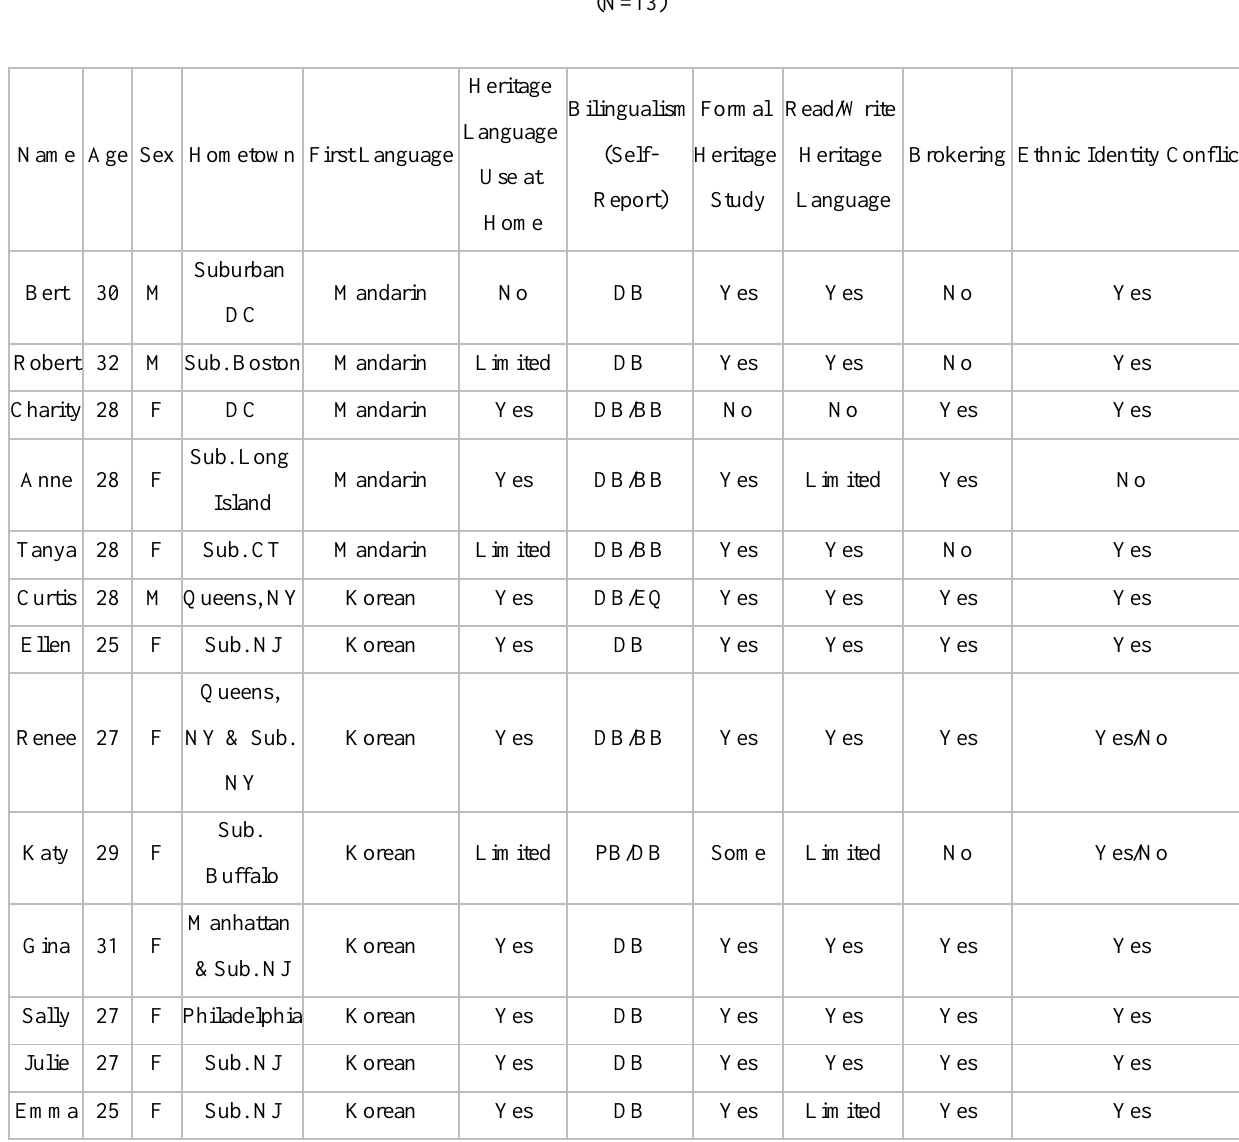
Background Information of the Study